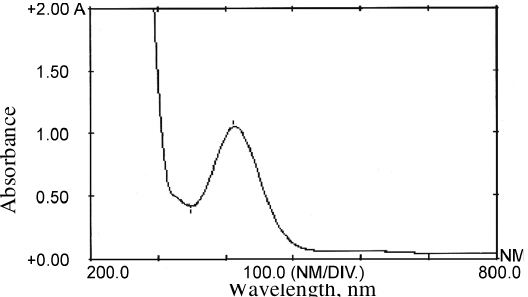
Figure 2. Absorption spectra of pioglitazone–BCG ion–pair complex in